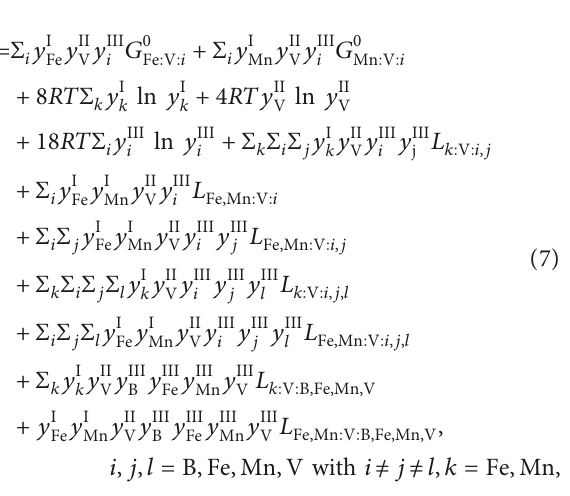
Figure 2: Calculated isothermal section of the phase diagram of the B-Mn-V system (a) at 973K, (b) at 1073K with experimental data points from literature [5], and (c) at